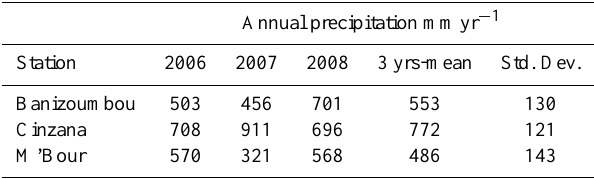
Table 1. Annual precipitation measured at the three stations of the Sahelian Dust Transect from 2006 to